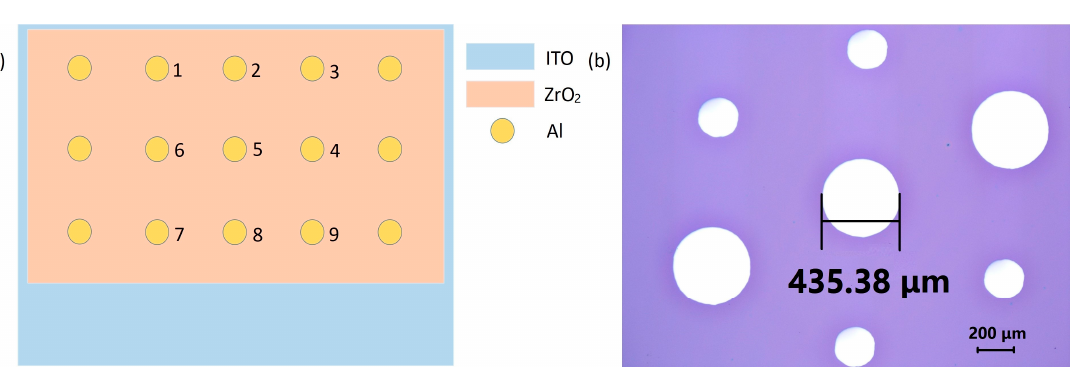
Figure 9. The overlook view of the MIM structure. ( a ) Overlook view. ( b ) Polarizing photograph.